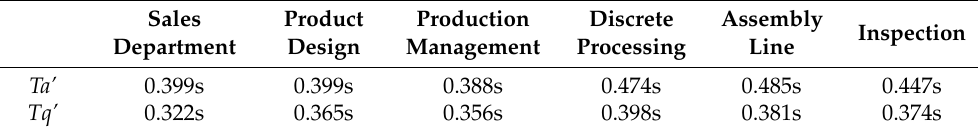
Table 2. The average value of Ta and Tq for each channel.